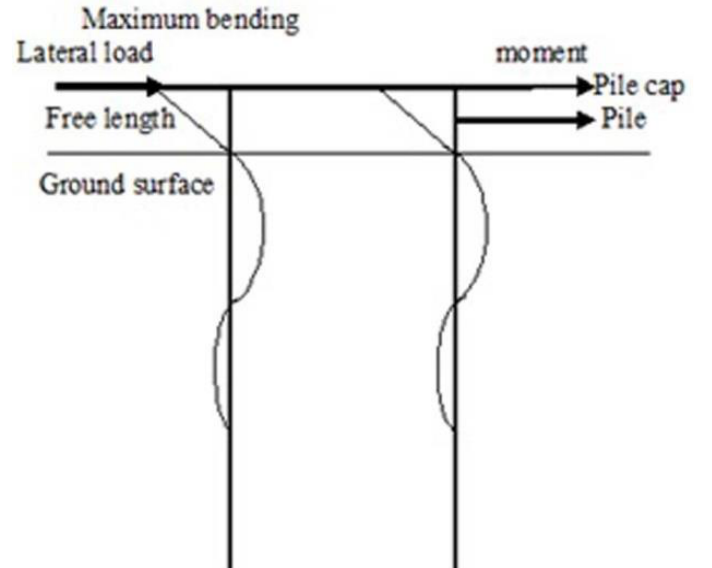
Fig. 11. Sketch of bending moment distributions free head pile group .